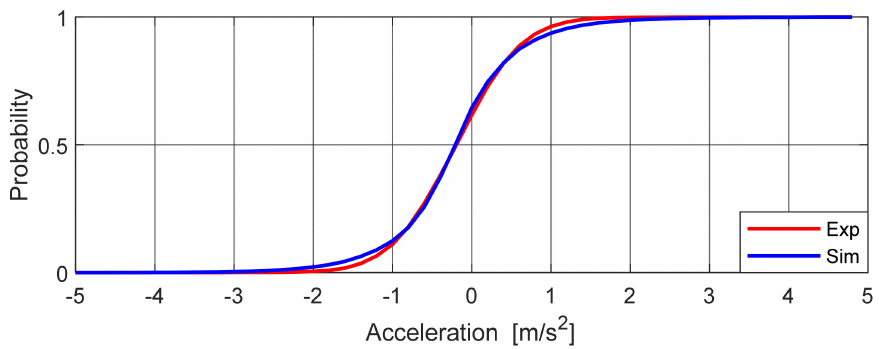
Figure 22. Distribution function, acceleration on vehicle FA.